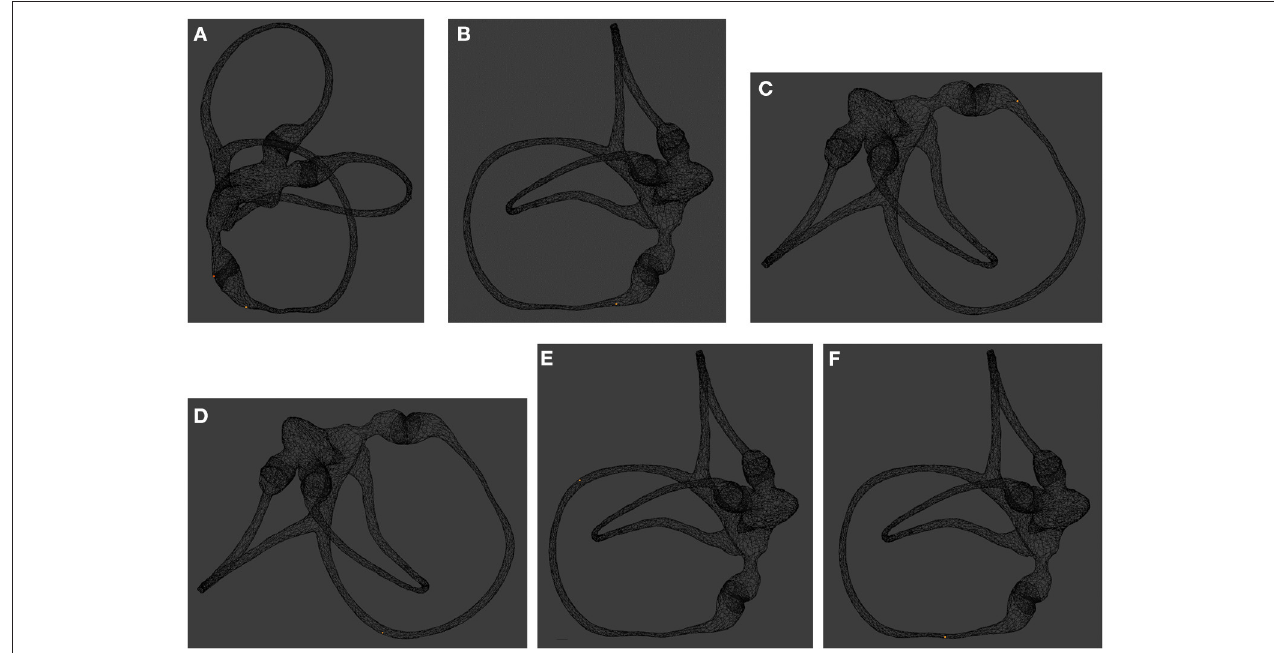
FIGURE 1 | Otolith position changes in the Dix-Hallpike test. (A) Image taken with the patient sitting upright, back view. The otolith is located on the short arm side or near the ampulla of the long arm side of the right posterior semicircular canal. (B) Turn the head 45 ◦ to the 0 right. Lateral view. (C,D) Images taken with the patient lying supine with the right ear down and the head tilted back 30 ◦ . The otolith is initially located near the ampulla of the long arm side of the right posterior semicircular canal, moved away from the ampulla for a long distance. (E,F) The otolith is initially far away from the ampulla and moves toward the ampulla under the action of gravity, but it cannot migrate to the previous position and keep a further distance from the